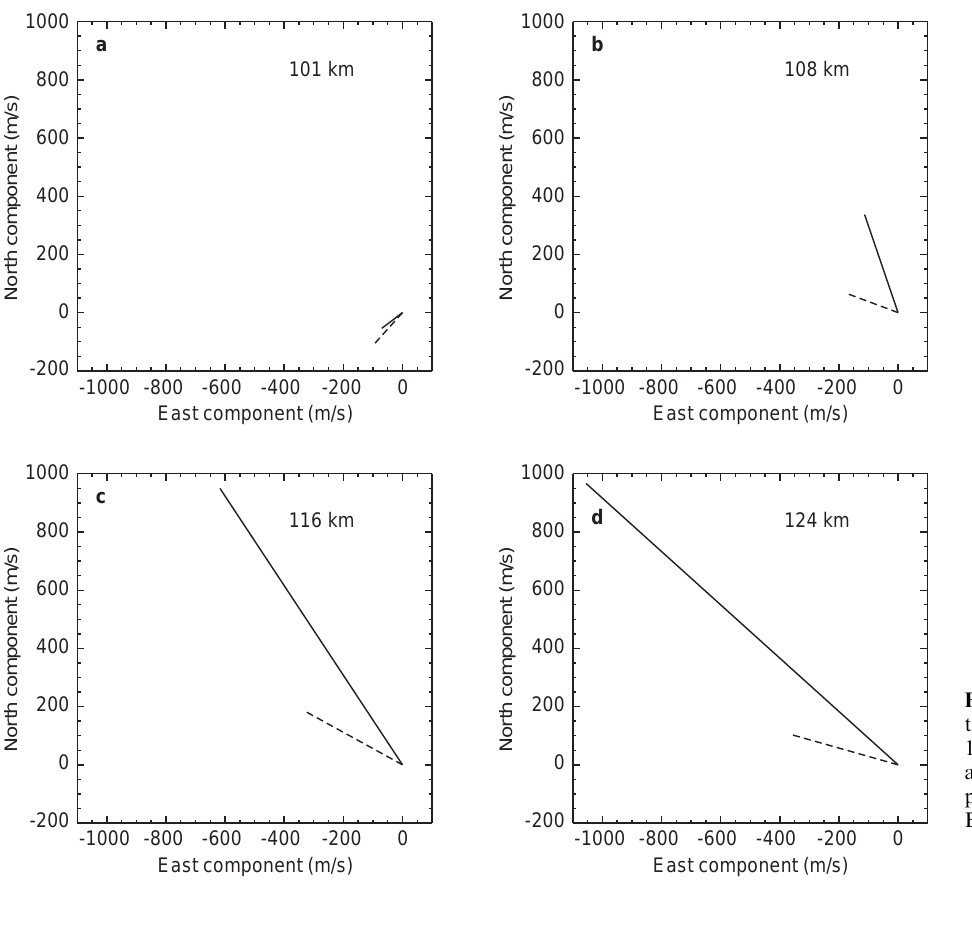
Fig. 7. Ion ( full lines ) and neu- tral ( dash line ) vectors at 101 ( a ), 108 ( b ), 116 ( c ) and 124 ( d ) km altitudes, derived using multi- position observations and